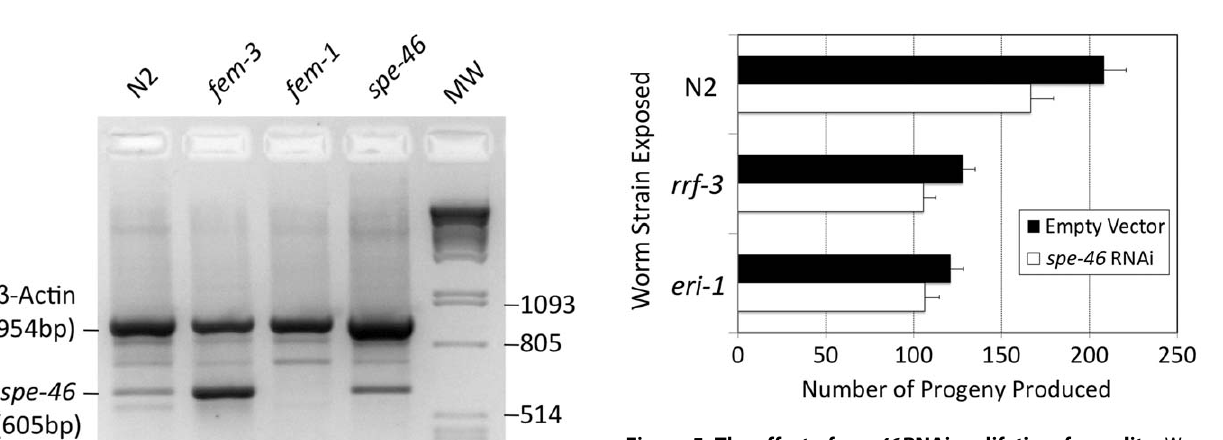
Figure 5. The effect of spe-46 RNAi on lifetime fecundity. Worms were exposed to transformed E. coli strain HT115 expressing dsRNA corresponding to the spe-46 transcript ( spe-46 RNAi) or to control bacteria transformed with only the RNAi vector, L4440 (empty vector). In addition to wild-type strain N2, the strains rrf-3 and eri-1 were utilized due to their increased sensitivity to RNAi. Error bars represent the